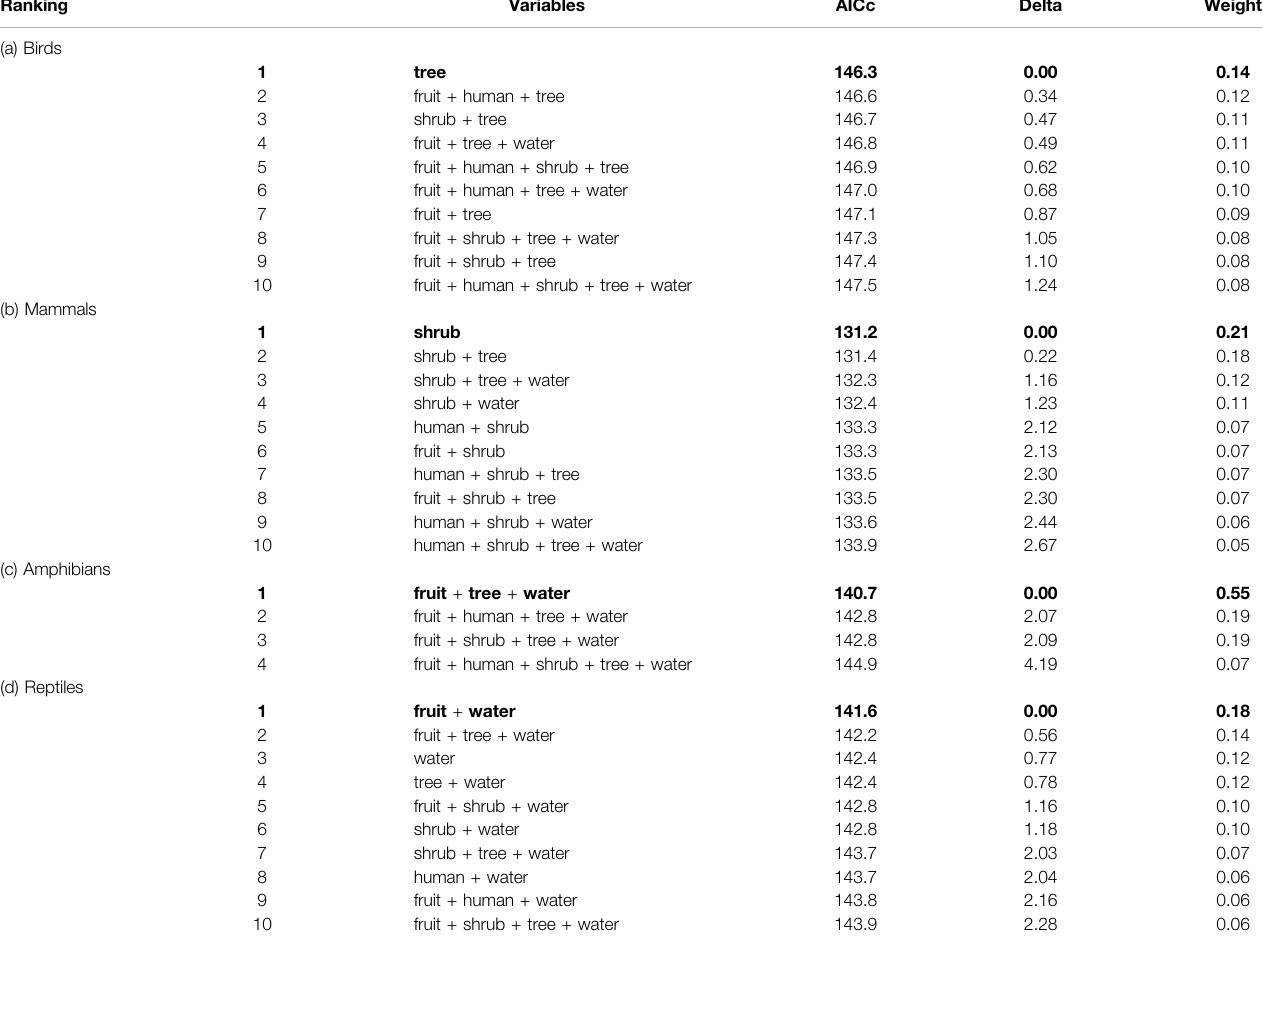
TABLE 3 | Ranking of the best statistical models which were retained in each con fi dence set, where the Akaike ’ s difference (Delta) with the top-ranked model was less than 5.0,followingtheInformationTheoreticapproach,for(a)birds,(b)mammals,(c)amphibians,and(d)reptiles.Themostparsimoniousmodelsareinbold.Weightrefersto the cumulative weight of the models starting from the top ranked model. Bold values signi fi es “ The most parsimonious models ” .